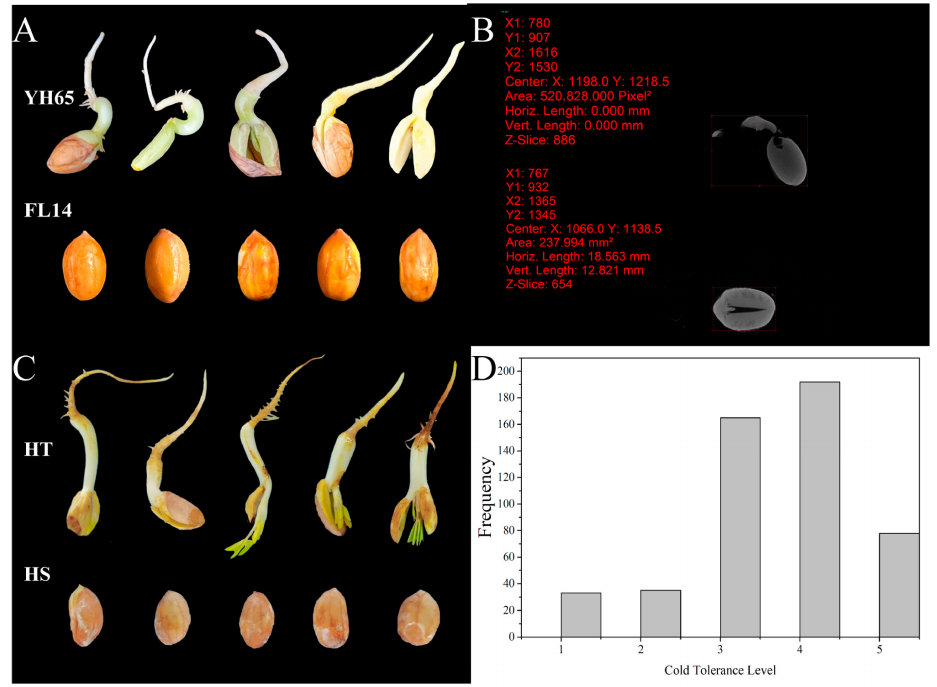
Figure 1. Phenotypic analysis of LTG at 7 d of rewarming germination. ( A ), The performance of two parental lines, YH65 and FL14. ( B ), Plant tomography system Ctportable scan image of seed internal structure of two parents. ( C ), The performance of extreme individuals, HT and HS. ( D ), Frequency distribution for LTG tolerance showing phenotypic variation in F 2